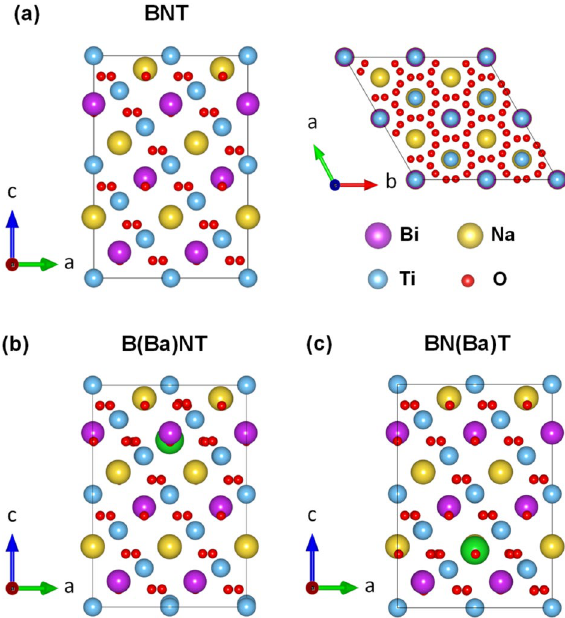
Figure 8. (a) Side and top views of the optimized atomic structure of Na 0.5 Bi 0.5 TiO 3 (BNT). The same with (b) Bi-site Ba [B(Ba)NT] and (c) Na-site Ba [BN(Ba)T] substitution.